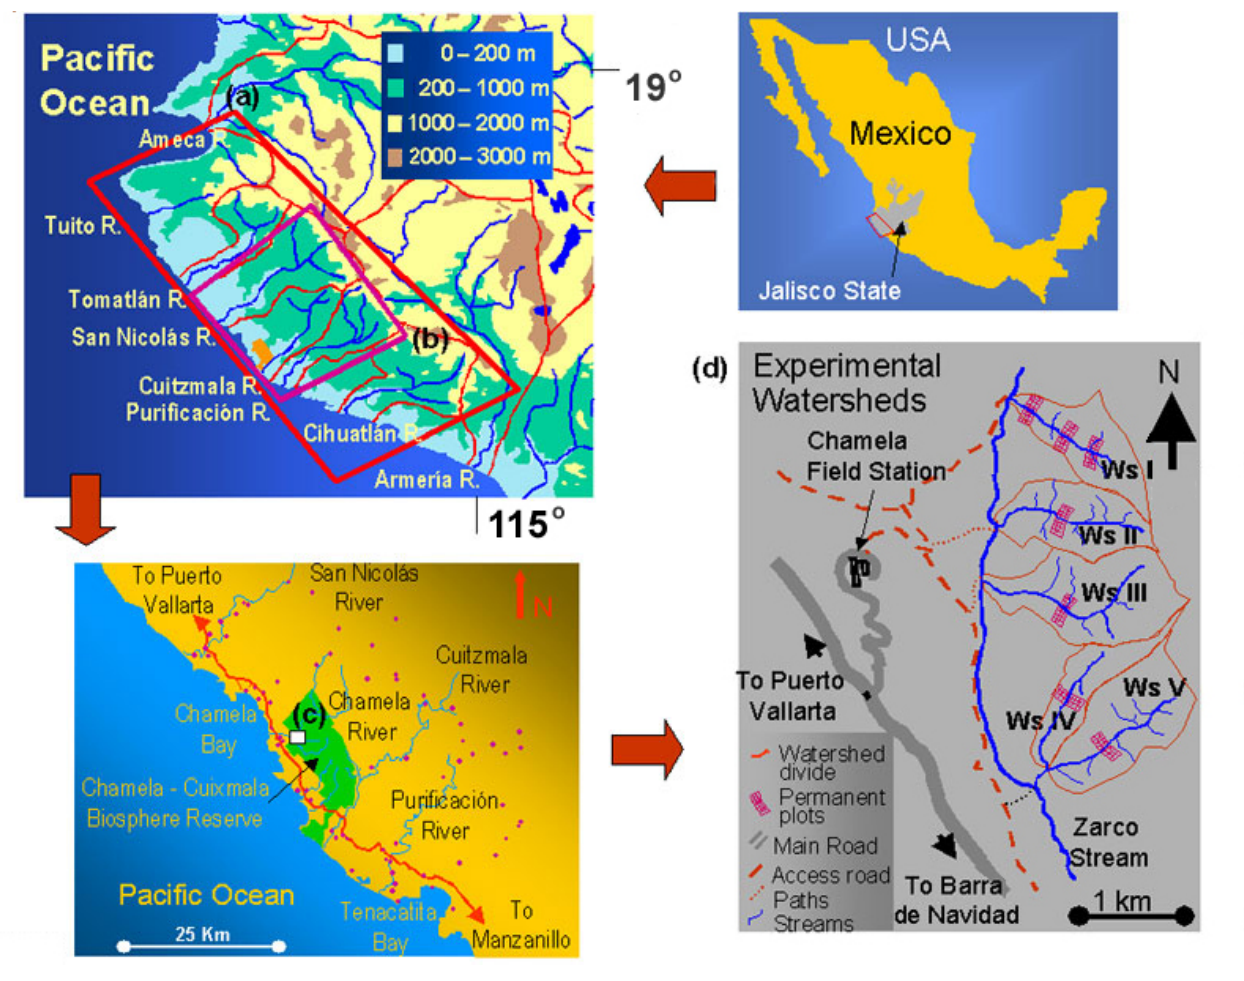
Fig. 2. Study site location and the four scales at which information relevant to the analysis of the ecosystem services delivered by a tropical dry forest region of western Mexico is available: (a) Pacific Coast, (b) Chamela Region, (c) Chamela-Cuixmala Biosphere Reserve, (d) Experimental watersheds. Dots around the Chamela-Cuixmala Biosphere Reserve represent human